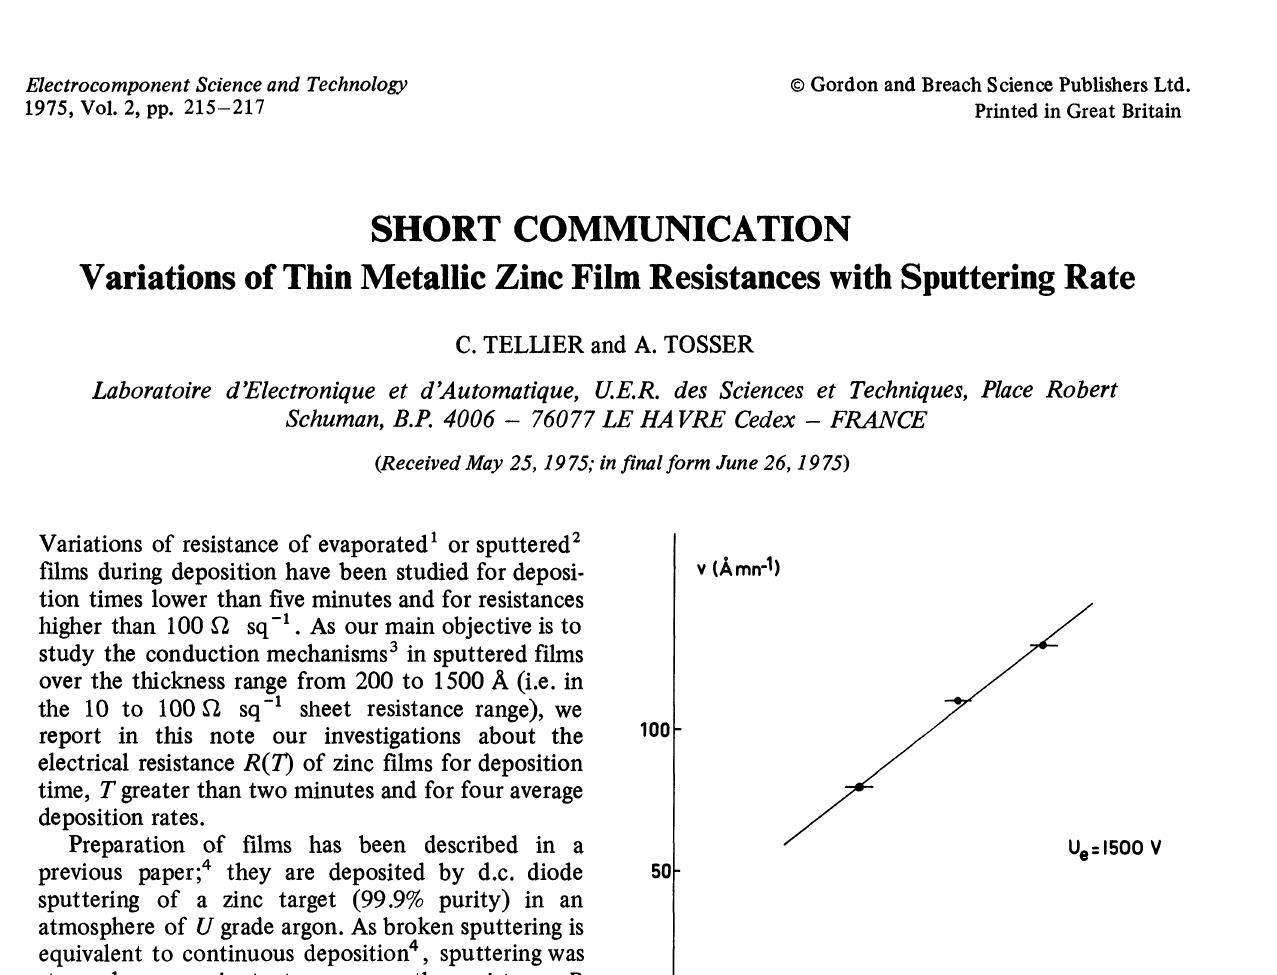
FIGURE Variations of the average sputtering rate v with the intensity Ie of the glow discharge.